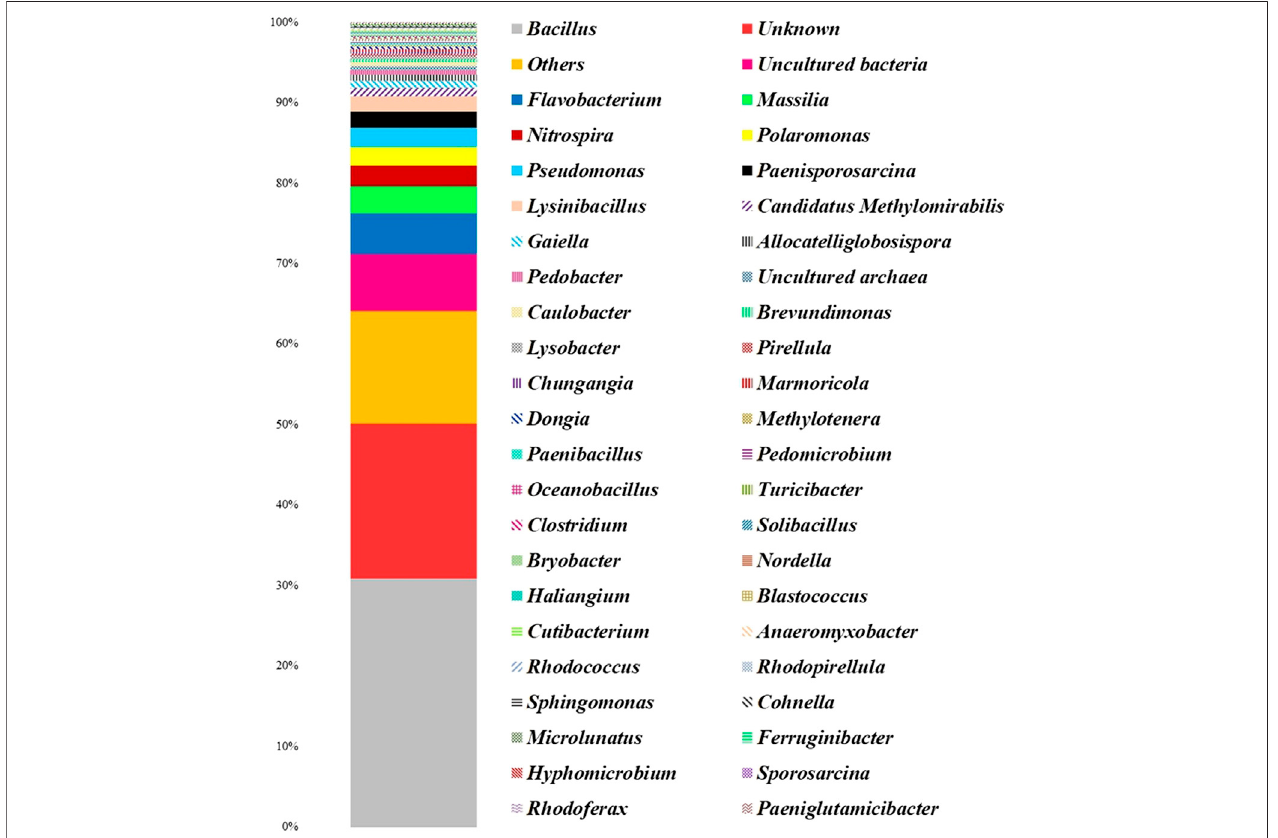
FIGURE 4 | Taxonomy bar chart at the genus level. The genera relative percentages were calculated on the sequencing results obtained from both sequenced samples.